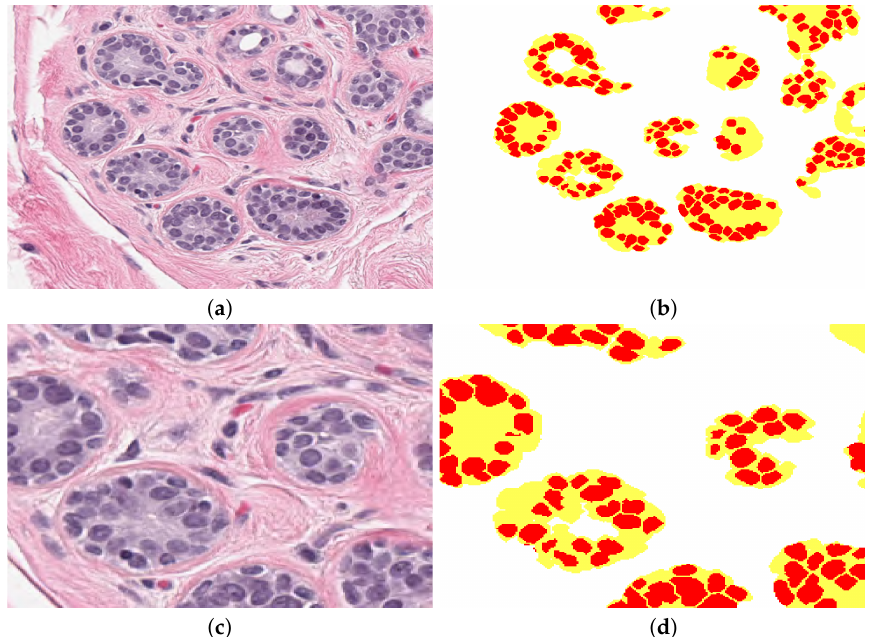
Figure 6. ( a ) The original patch with clear breast ducts. ( b ) Clusters detected by the methodology, every duct or cluster is in yellow and cells inside are in red. Background is labelled in white. ( c , d ) Magnified regions of ( a , b